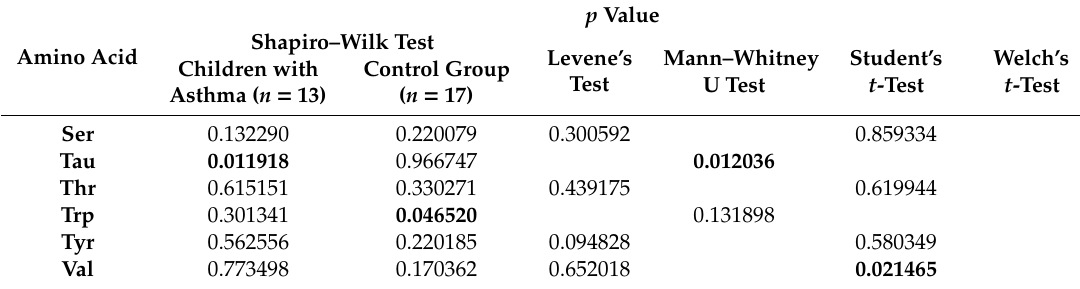
( b ) Figure 1. Results of a partial least squares discriminant analysis (PLS-DA) of free amino acid profiles determined in children with asthma and the control group. ( a ): Three-dimensional score plot (with explained variances shown in brackets). ( b ): The variables having the greatest importance in sample